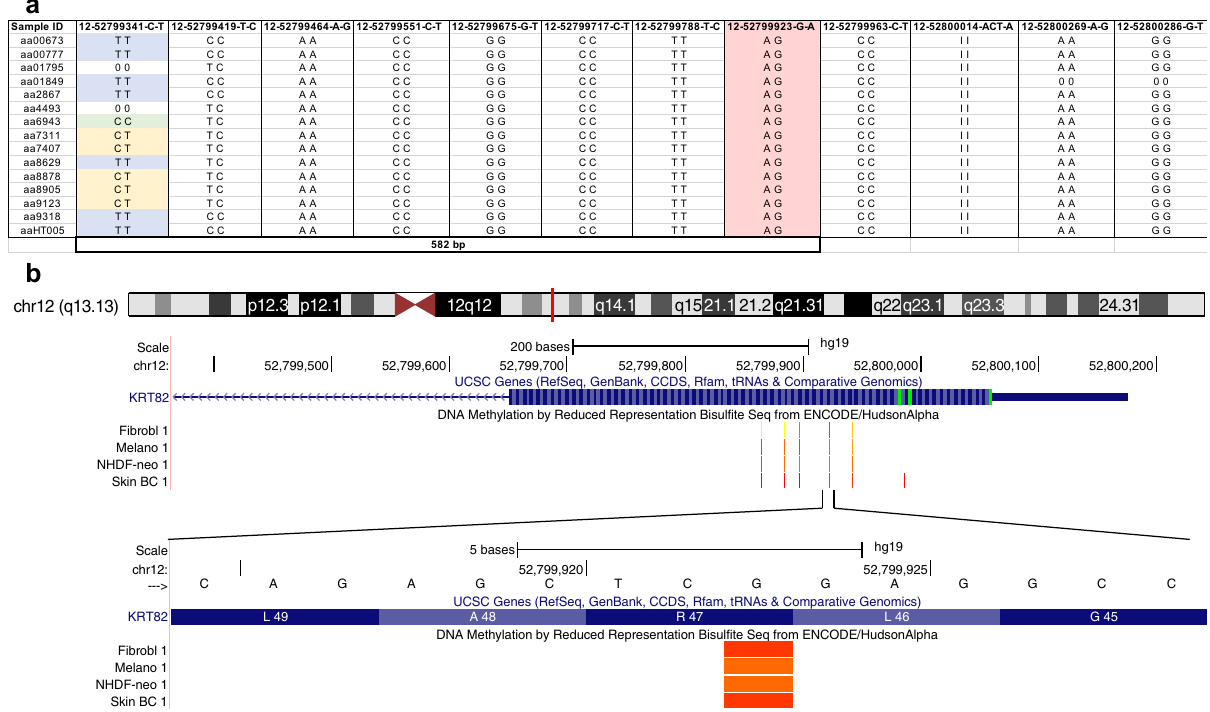
Fig. 5 Haplotype analysis identi fi es Arg47X as a hotspot mutation. a 15 AA patients heterozygous for the Arg47X variant (12-52799923-G-A; highlighted in pink). Different genotypes (blue = alternate homozygous, yellow = heterozygous, green = reference homozygous) at variant 12-52799341- C-T (582 bp away) con fi rms the presence of the Arg47X A allele on different haplotypes, identifying it as a hotspot mutation. b Schematic of KRT82 exon 1 (blue) with ENCODE methylation patterns (orange) in 4 skin cell types: fi broblasts (Fibrobl), Melanocytes (Melano), Neonatal Dermal Fibroblasts (NHDF- neo), and Skin Tissue (Skin BC). This is a visualization of the methylated cytosine (C) of the sense strand that is spontaneously deaminated resulting in a mutational hotspot and premature stop codon at position 47.